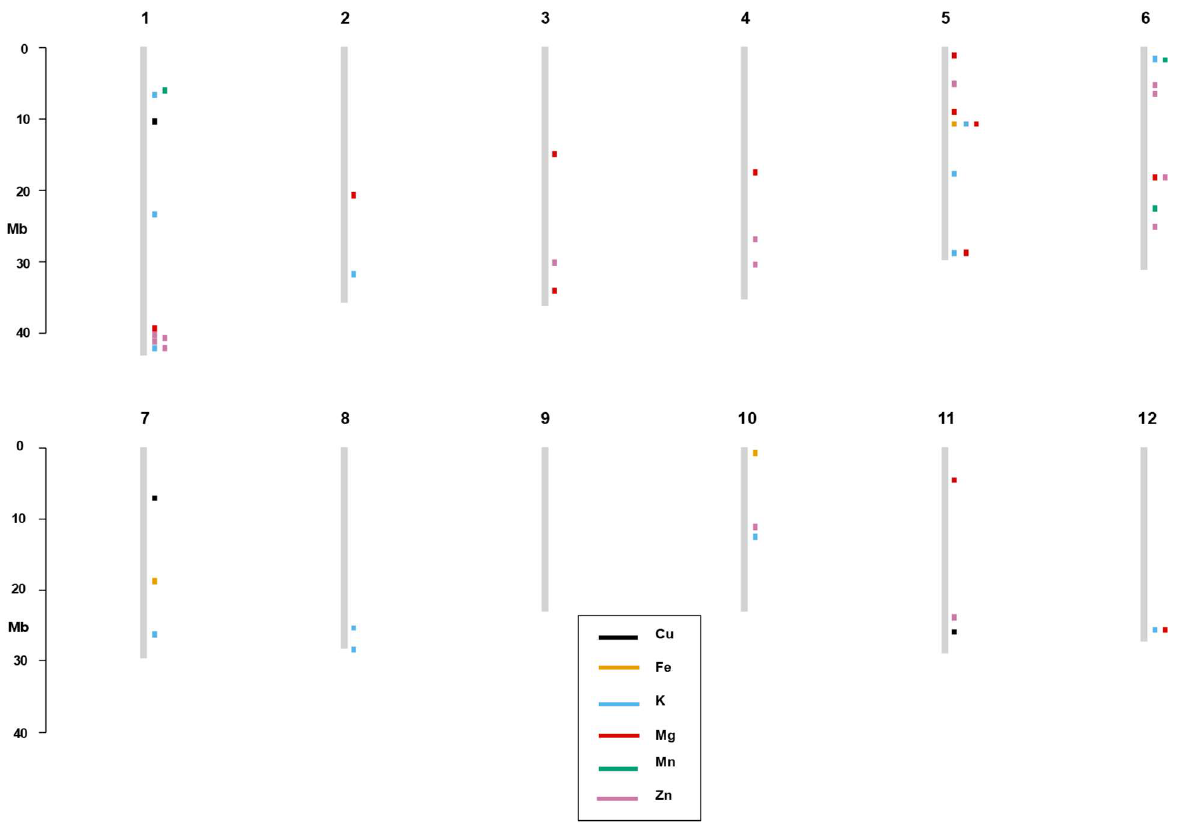
Figure 6. Physical map of the significant SNP markers after applying 15% FDR multi-test correction found in the study for the six mineral elements. SNP positions are depicted by the rectangular box with specific color showing the corresponding mineral elements. Rice chromosomes are displayed by vertical lines.